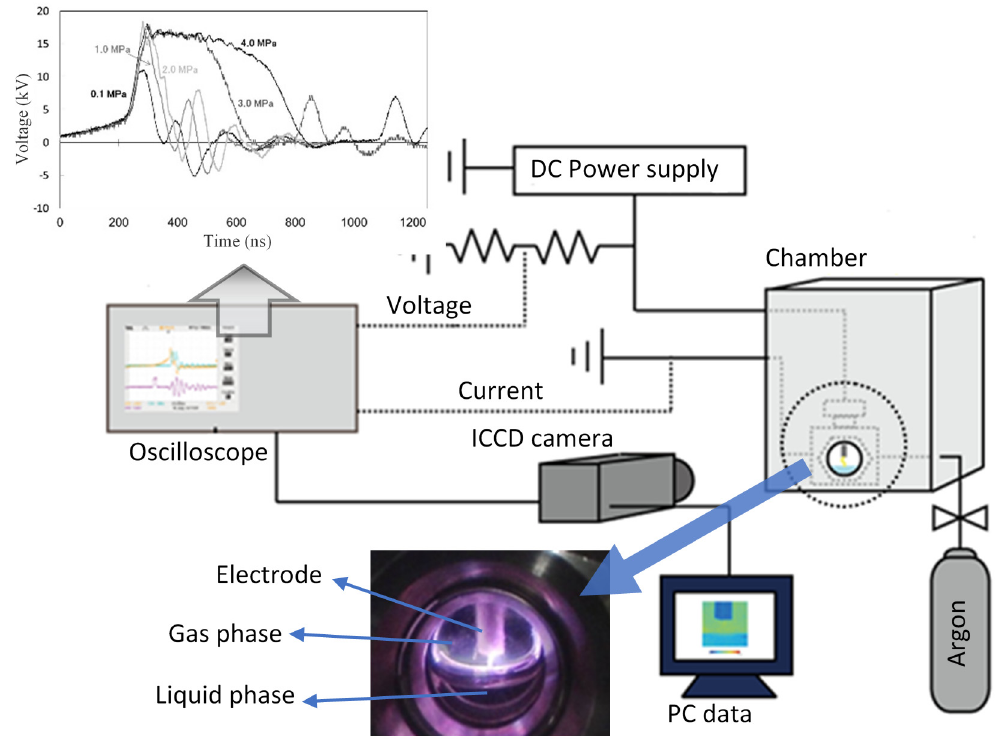
Figure 1. Experimental apparatus scheme.